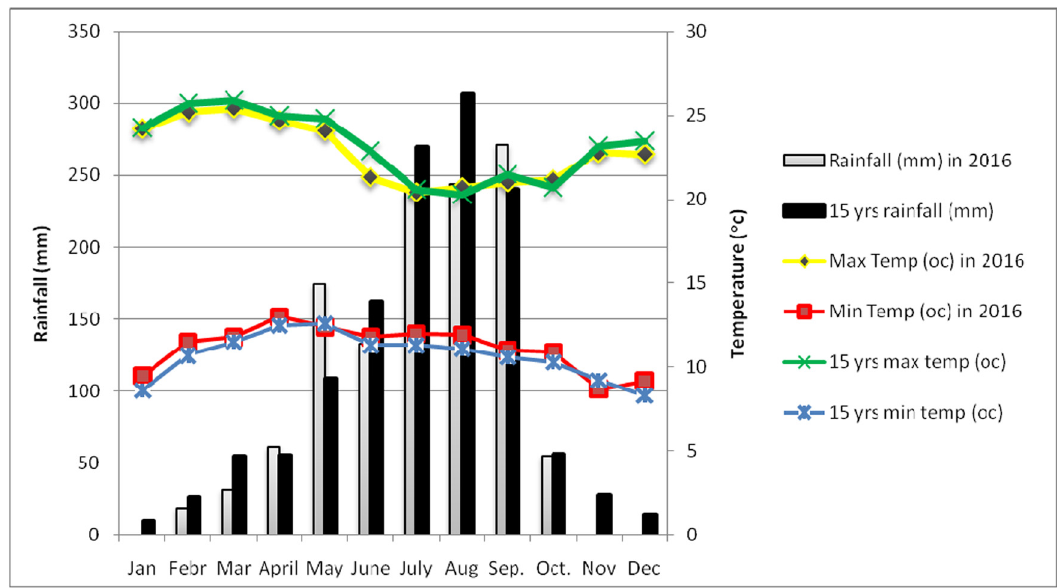
Figure 2: Monthly average rainfall and maximum and minimum temperatures of the study site for 15 years ( 2003 – 2017 )